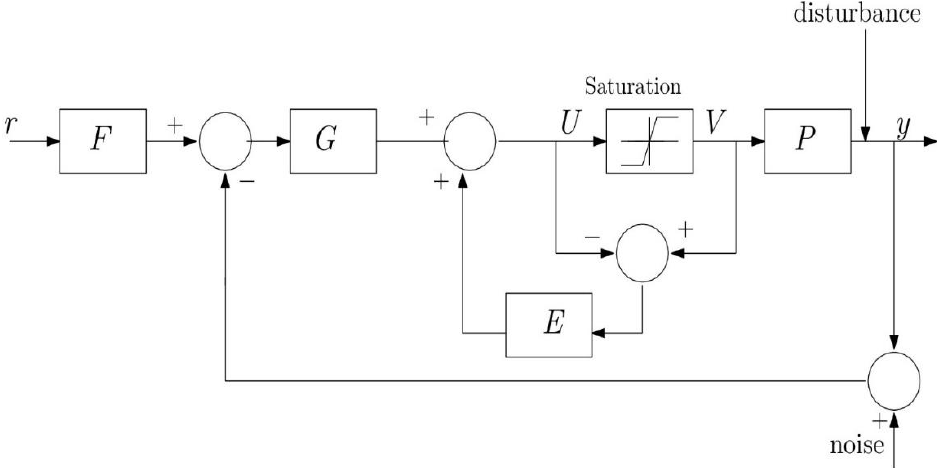
Figure 3. A 3-DOF non-interfering control structure.